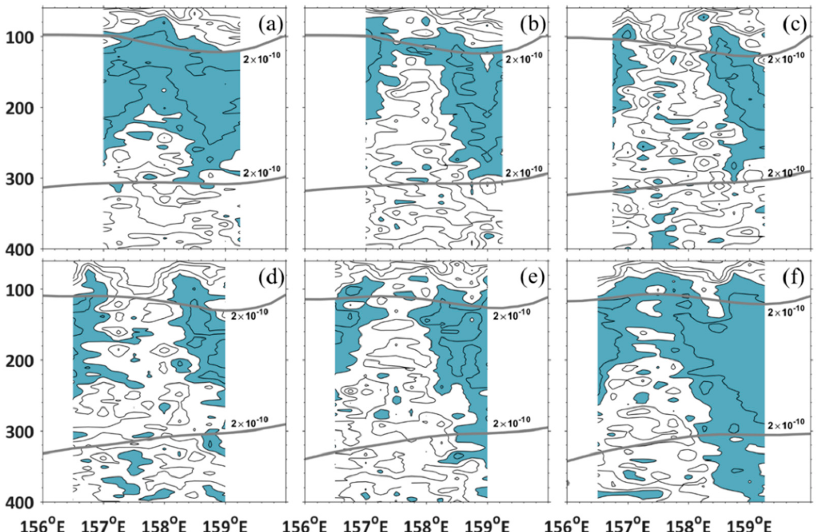
Figure 8. Subtropical Mode Water (STMW). ( a ), ( b ), ( c ), ( d ), ( e ) and ( f ) are for the sections of S1, S2, S3, S4, S5 and S6, respectively. The potential vorticity smaller than 2 (cid:3400) 10 (cid:2879)(cid:2869)(cid:2868) m (cid:2879)(cid:2869) s (cid:2879)(cid:2869) is used to identify STMW between 25.3 and 25.5 𝜎 (cid:3087) , which is nattier blue shaded. The gray line denotes the STMW between 25.3 and 25.5 σ θ , which is nattier blue shaded. The gray line denotes the climatological potential vorticity of 2 × 10 − 10 m − 1 s − 1 .